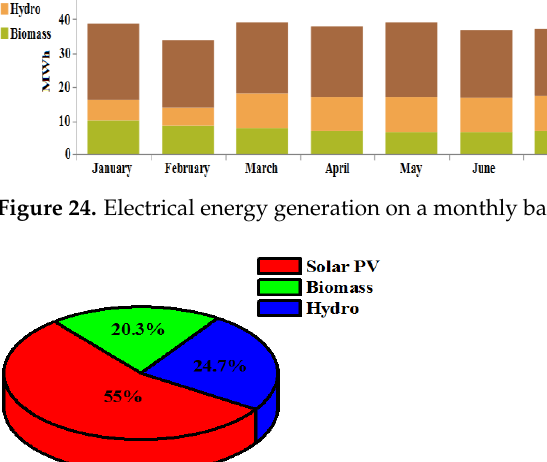
Figure 25. Renewable energy generation percentage for case IV (Ba/Bi/H/S).